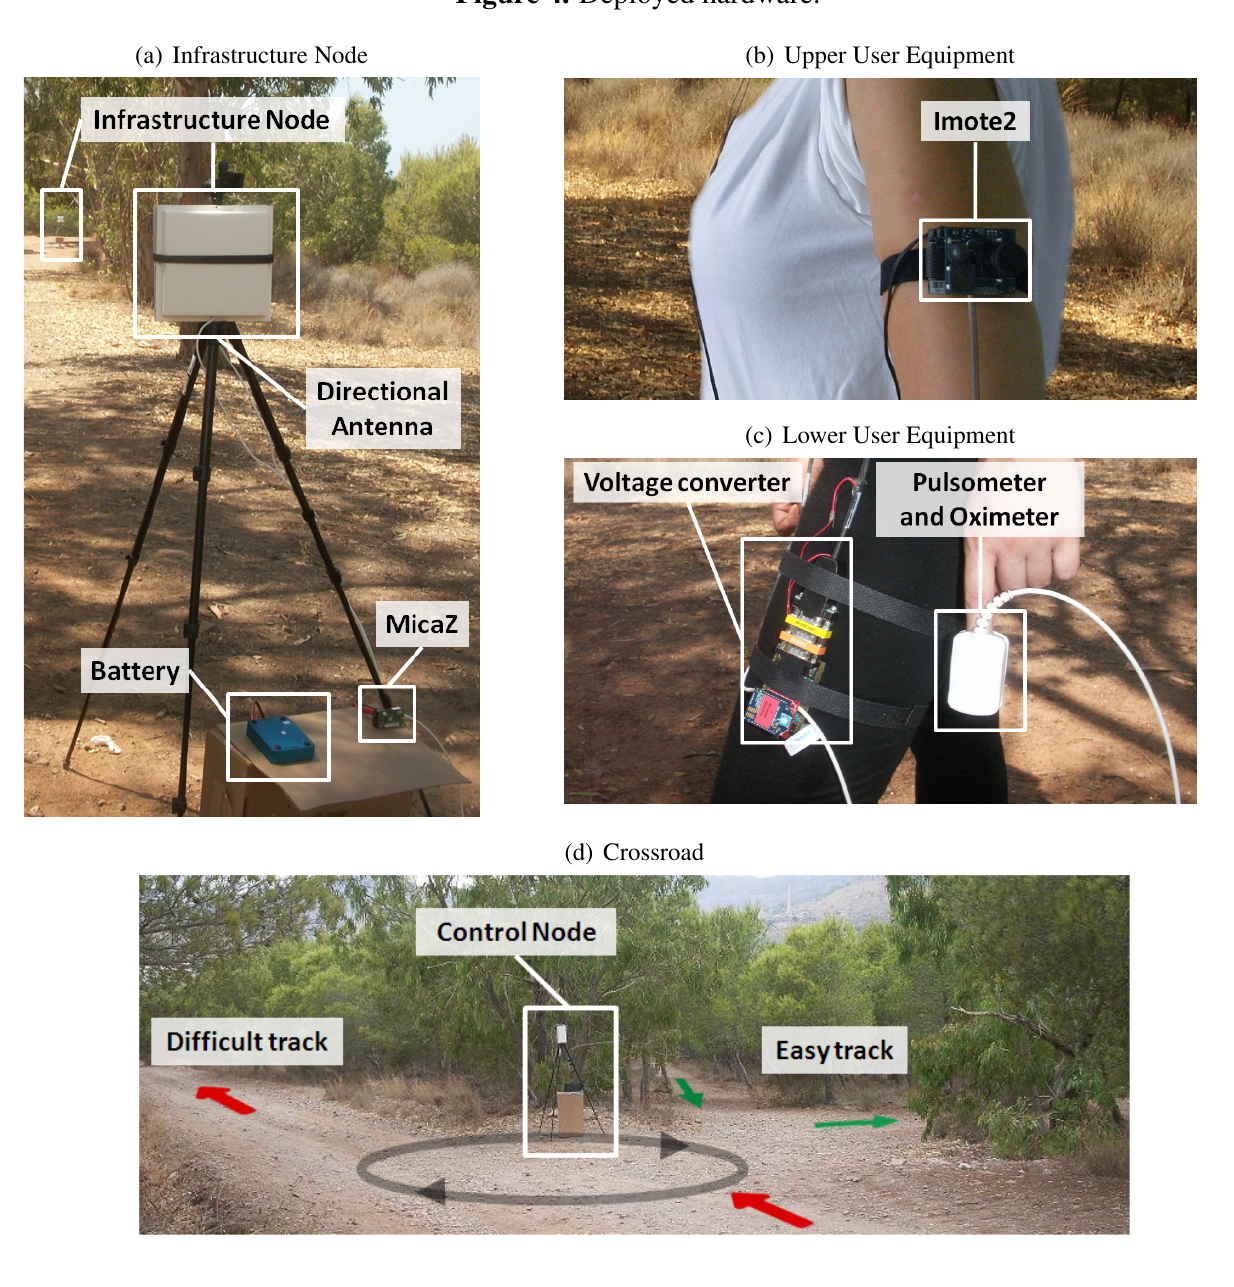
Figure 4. Deployed